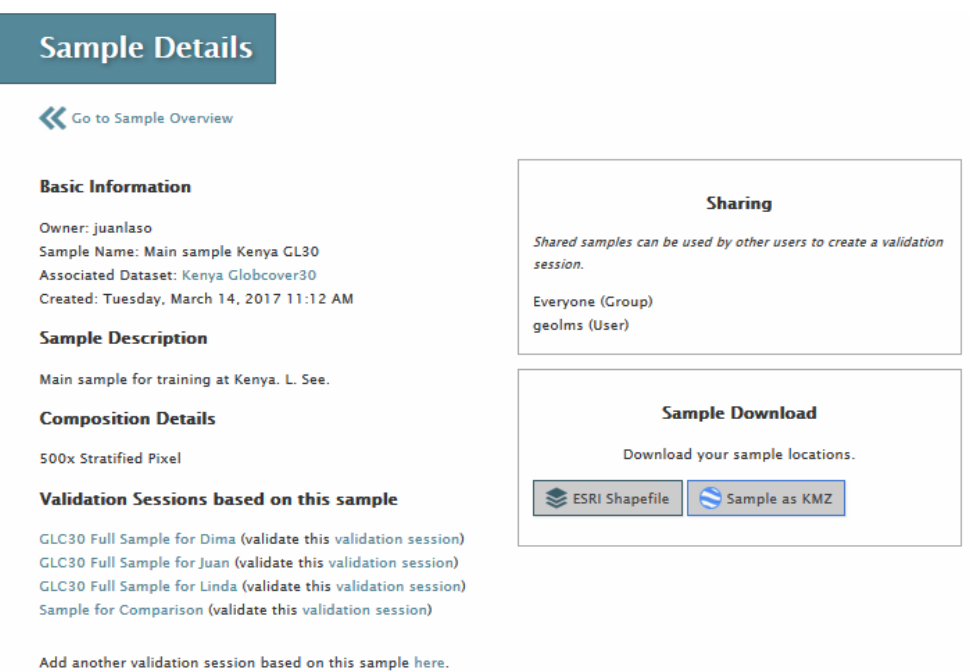
Figure 6. Details about a sample in LACO-Wiki. This sample can be shared, downloaded or used to create a validation session.